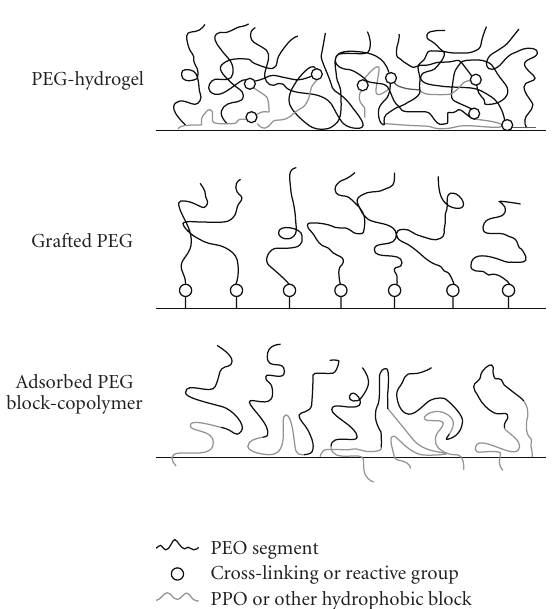
Figure 2: Schematic drawing that shows the structural features of PEG layers obtained by di ff erent coating: photo-polymerization, grafting and adsorption